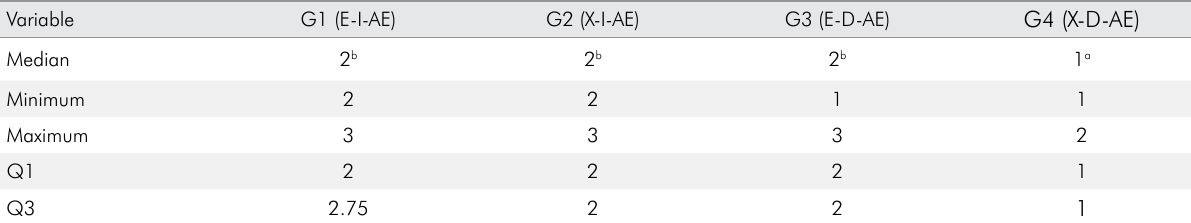
Table 2. Median, maximum and minimum values, and the first and third quartile of the scores attributed to the remaining epoxy resin-based sealer (AH Plus) residues, according to the cleaning chemical protocol and acid etching time-point (n = 10, each group).